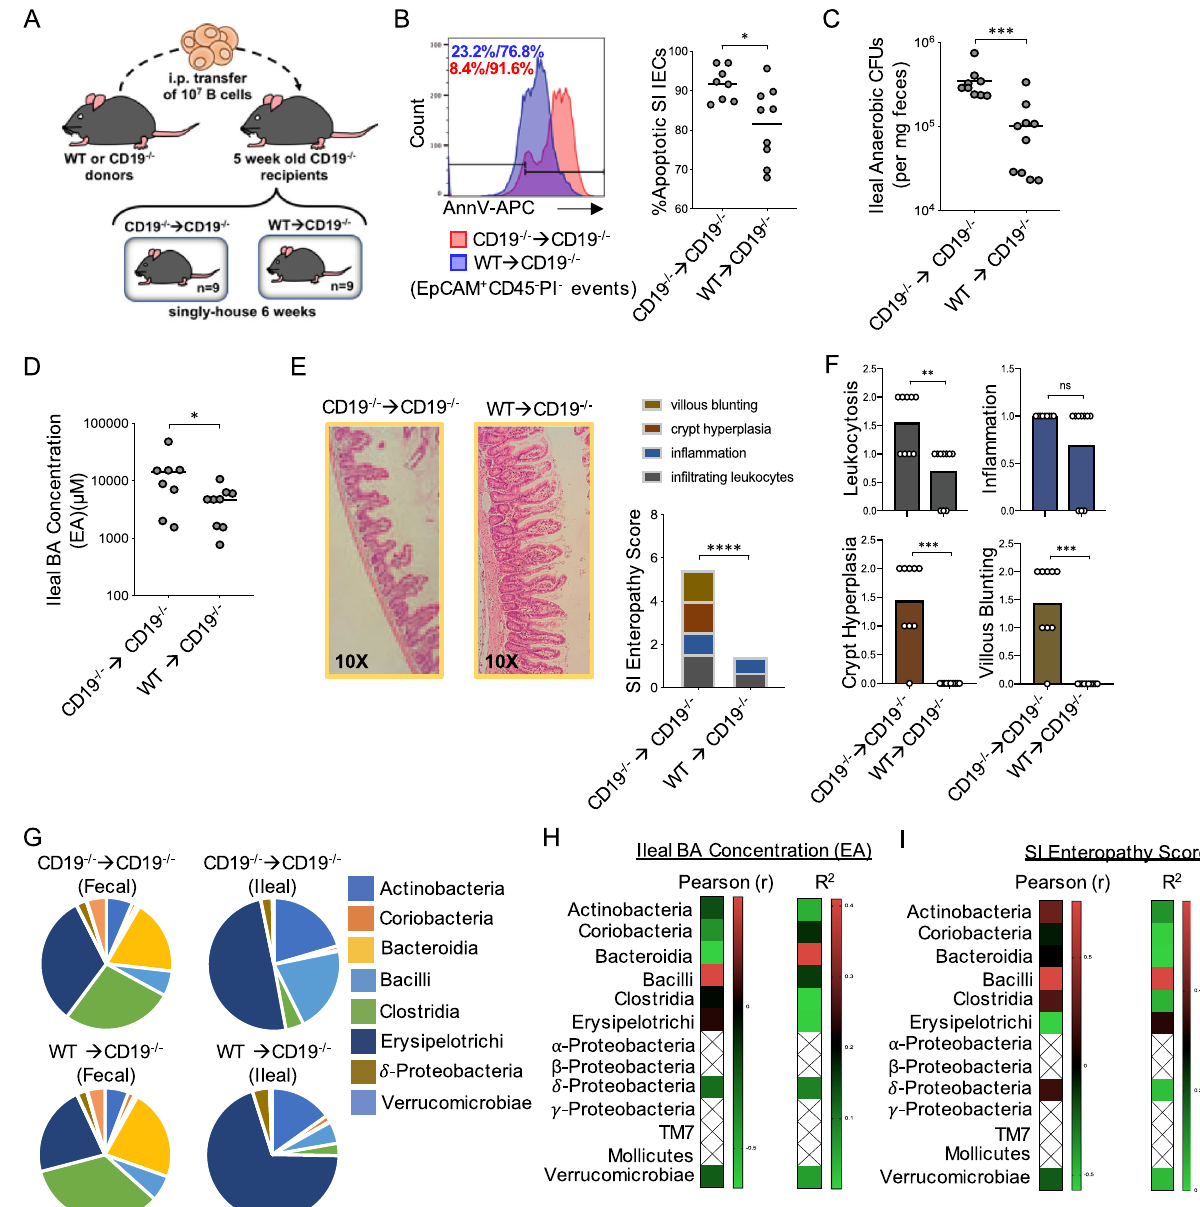
Fig. 5 Adoptive transfer of WT B cells rescues CD19 − / − mice from SI enteropathy. A Schematic of adoptive transfer experiment. B Representative histogram plot demonstrating gating on apoptotic IECs and results of fl ow experiments are shown. Two-tailed unpaired Student ’ s t-test with Welch ’ s correction for uneven variance; * = p = 0.01. C Anaerobic CFU titers from ileal contents are shown. Two-tailed unpaired Mann – Whitney U test; *** = p = 0.0006. D Total ileal BA concentrations are shown. Two-tailed unpaired Student ’ s t-test; * = p = 0.05. E SI enteropathy scoring is shown for CD19 − / − mice receiving B cells from WT or CD19 − / − mice. Two-tailed unpaired Mann – Whitney U test; **** = p < 0.0001. F Comparison of individual features of SI enteropathy between CD19 − / − mice receiving B cells from WT or CD19 − / − mice. Two-tailed unpaired Mann – Whitney U test; ns = non- signi fi cant = p = 0.21, ** = p = 0.004, *** = p = 0.0001 (crypt hyperplasia), *** = p = 0.0001 (villous blunting). G Pie-charts illustrating differential abundance of major bacterial Classes are shown. Source data are provided as a Source Data fi le. H Heatmaps summarizing descriptive statistics (Pearson r-coef fi cient and r-squared) of relationship between ileal bacterial group abundance and ileal BA concentrations are shown. I Heatmaps summarizing descriptive statistics (Pearson r-coef fi cient and r-squared) of relationship between ileal bacterial group abundance and SI Enteropathy severity are shown. B – I Data representative of two replicate experiments. H , I Hatched values indicate bacterial groups that were not found present in more than 75% of samples, and were thus excluded from Bacterial bsh activity is perturbed in the SI of CD19 − / − mice . (Supplementary Fig. S10B and Supplementary Data 2), and the abundance of Lactobacillaceae bacteria was also found to be Bacteria encode several genes essential to BA metabolism in the gut, positively correlated with ileal BA concentrations (Supplementary including the rate-limiting enzyme bile salt hydrolase ( bsh) that is Fig. S10C) and SI enteropathy scores (Supplementary Fig. S10D). responsible for BA deconjugation 27,28 . Given the enhanced